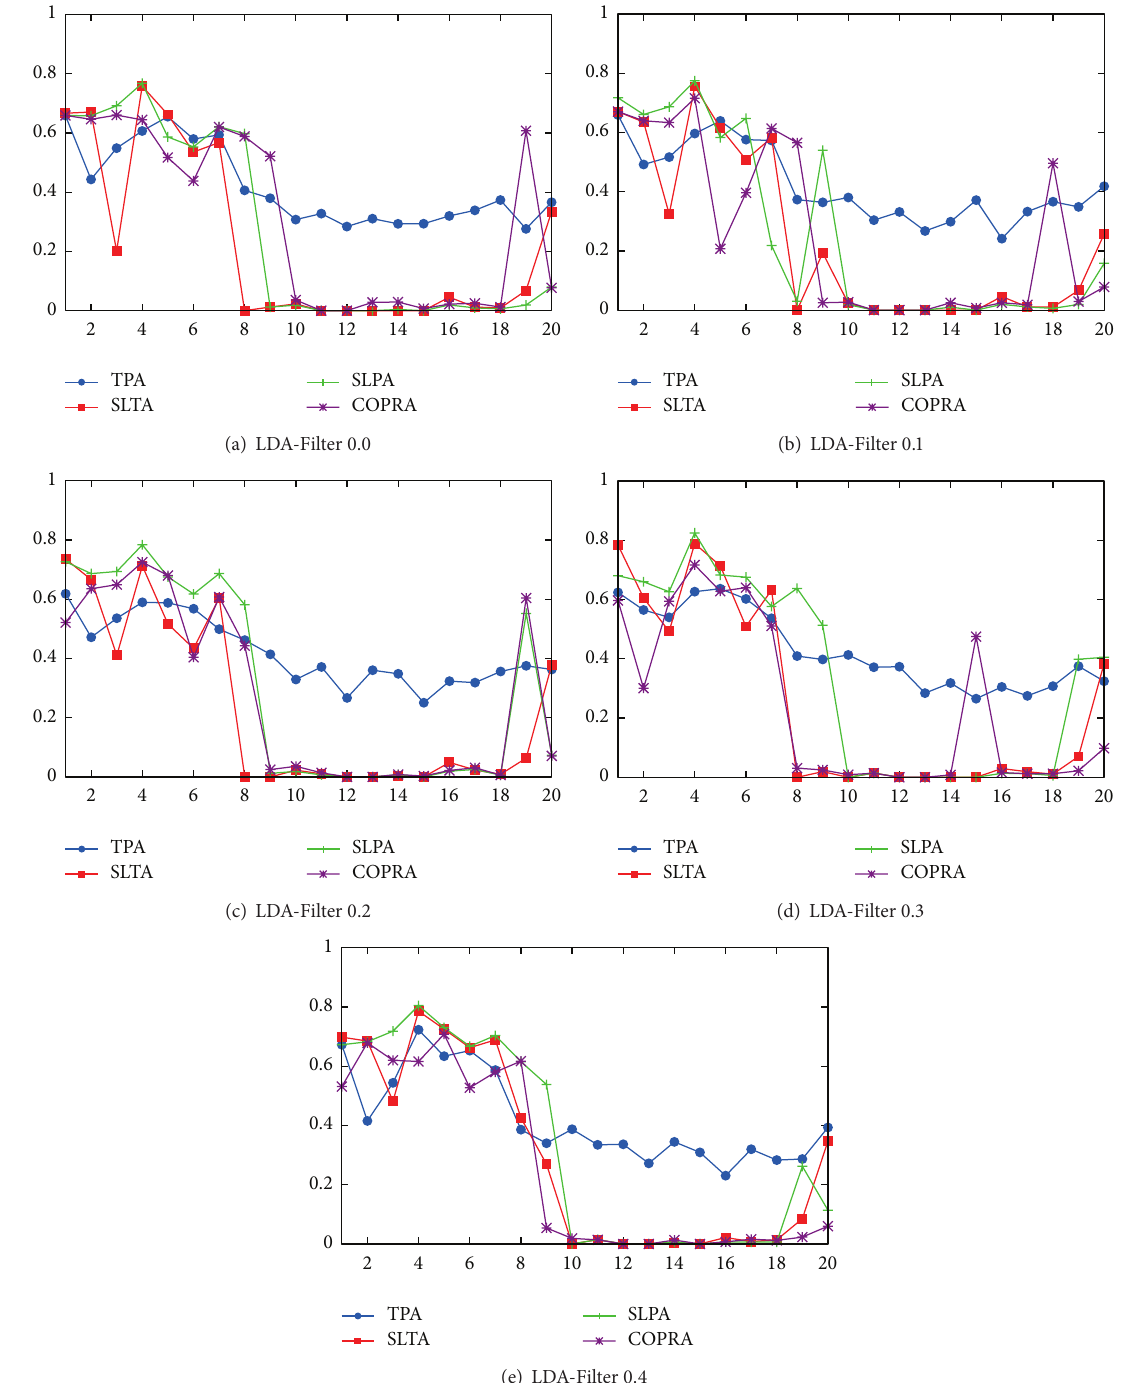
Figure 1: Algorithm modularity comparison for four-month TVC. (Figures include the period from Jan. 2004 to Aug.